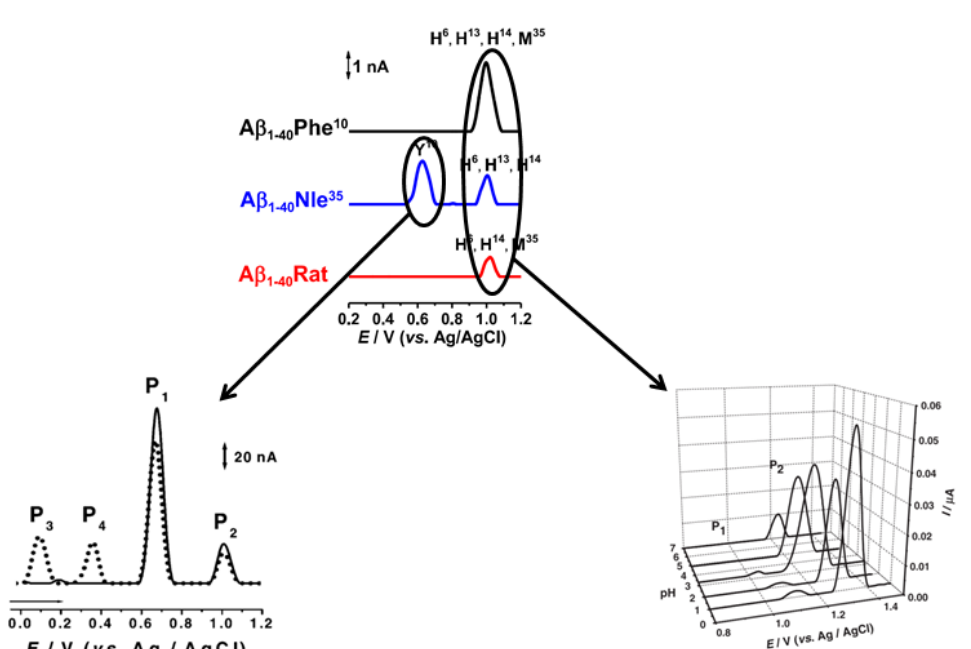
Figure 1 - Comparison between voltammograms of β-amloyd (top), adapted from (Enache et al. 2016) and the free amino acids L-Tyr (bottom, left), adapted from (Enache and Oliveira-Brett 2011a) and L-Met (bottom, right), adapted from (Enache and Oliveira-Brett 2011c), showing that the potential peak is the same for the bonded and free amino